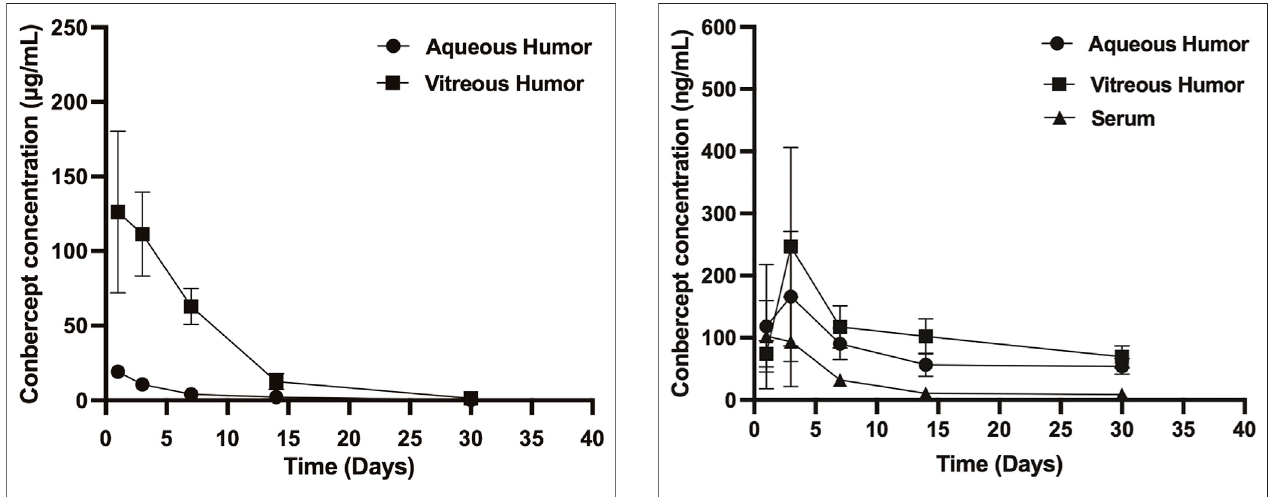
FIGURE 2 | Conbercept concentration in the vitreous humor, aqueous humor,andserumafterintravitrealinjectionof0.5 mgofconbercept.Samples were taken from the aqueous and vitreous of the non-injected